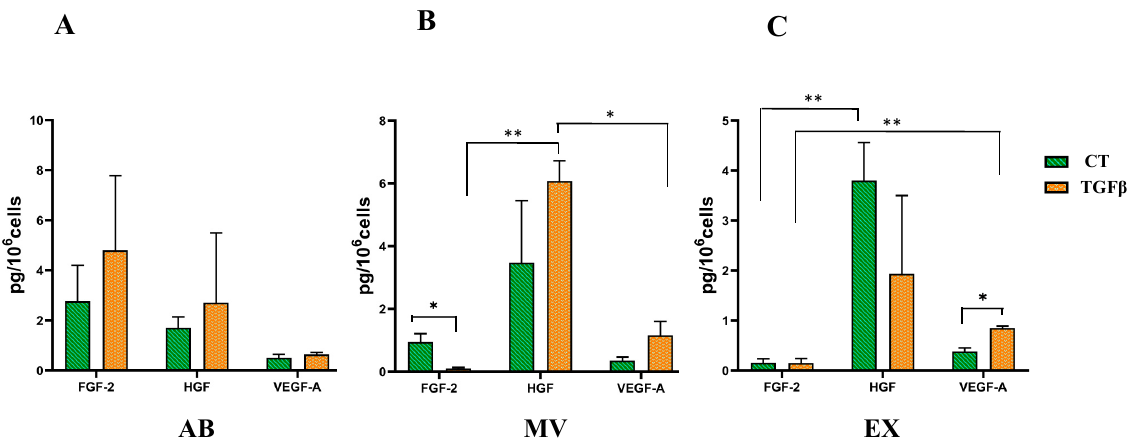
Figure 2. Quantification of growth factors including FGF-2, HGF, and VEGF-A using Luminex assay. ( A ) AB population in which there was no difference in all three factors between the two conditions. ( B ) MV population in which the highest levels of analyzed growth factors belong to HGF, and FGF-2 was more highly expressed in MVs from the control group. ( C ) EX population in which HGF was present in the greatest amount compared to FGF-2 and VEGF-A, and VEGF-A was expressed higher in the TGF β -stimulated UCMSC group. CT: control group (UCMSCs cultured in normal condition), TGF β : TGF β -stimulated UCMSC group, AB: apoptotic bodies, MV: microvesicles, EX: exosomes. N = 3, * indicates p < 0.05; ** indicates p < 0.01.